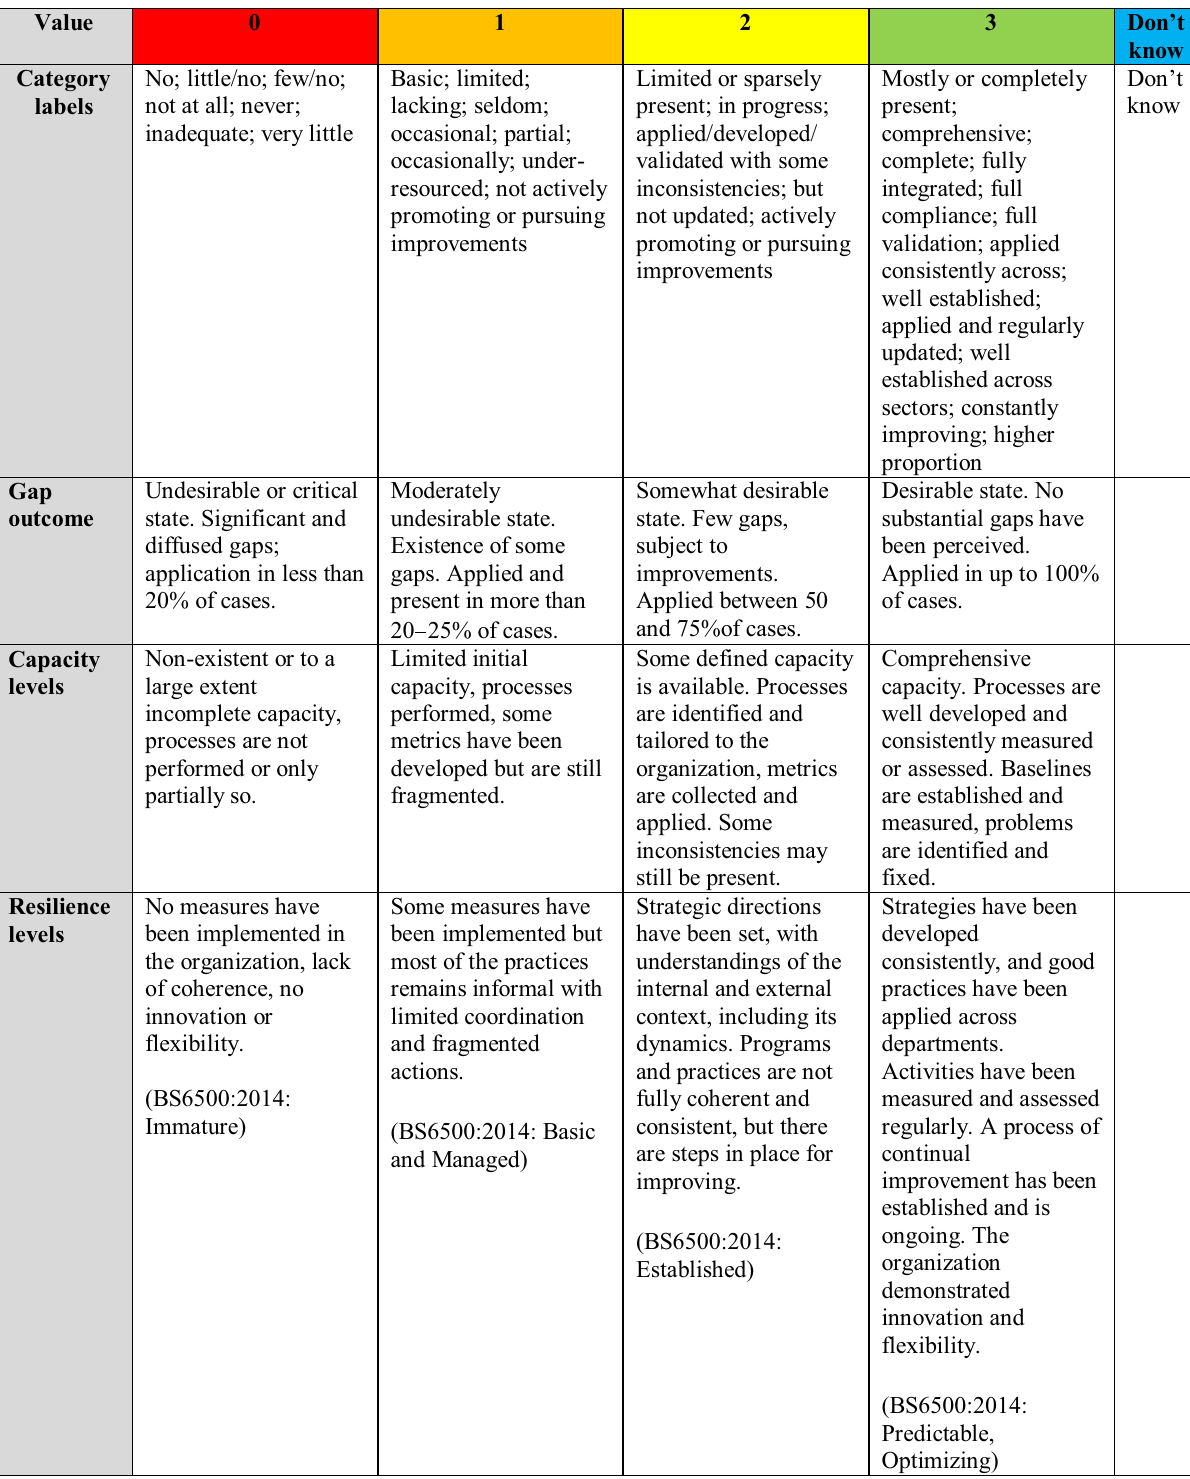
Table 1 A Likert scale-based response model for benchmarking gaps in operational capacity, organizational resilience, and disaster risk reduction capacity